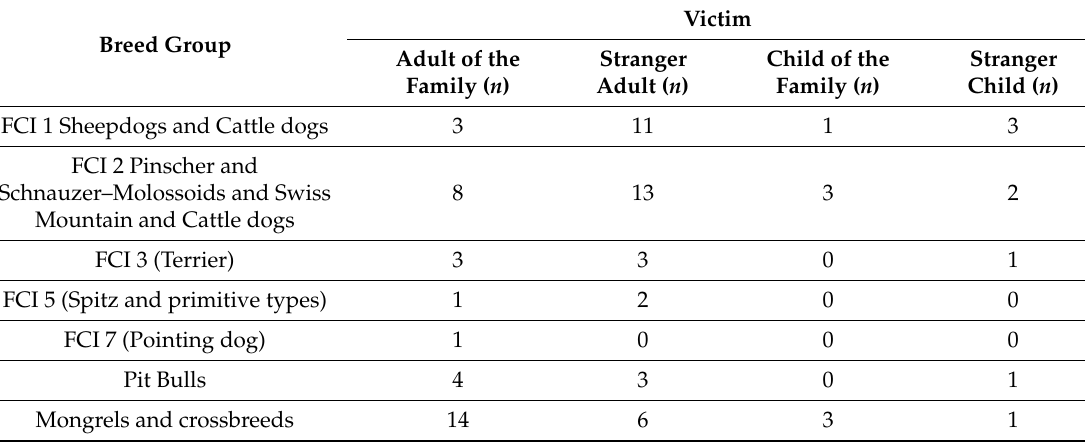
Table 15. Comparison of the type of victim and dog breed groups.